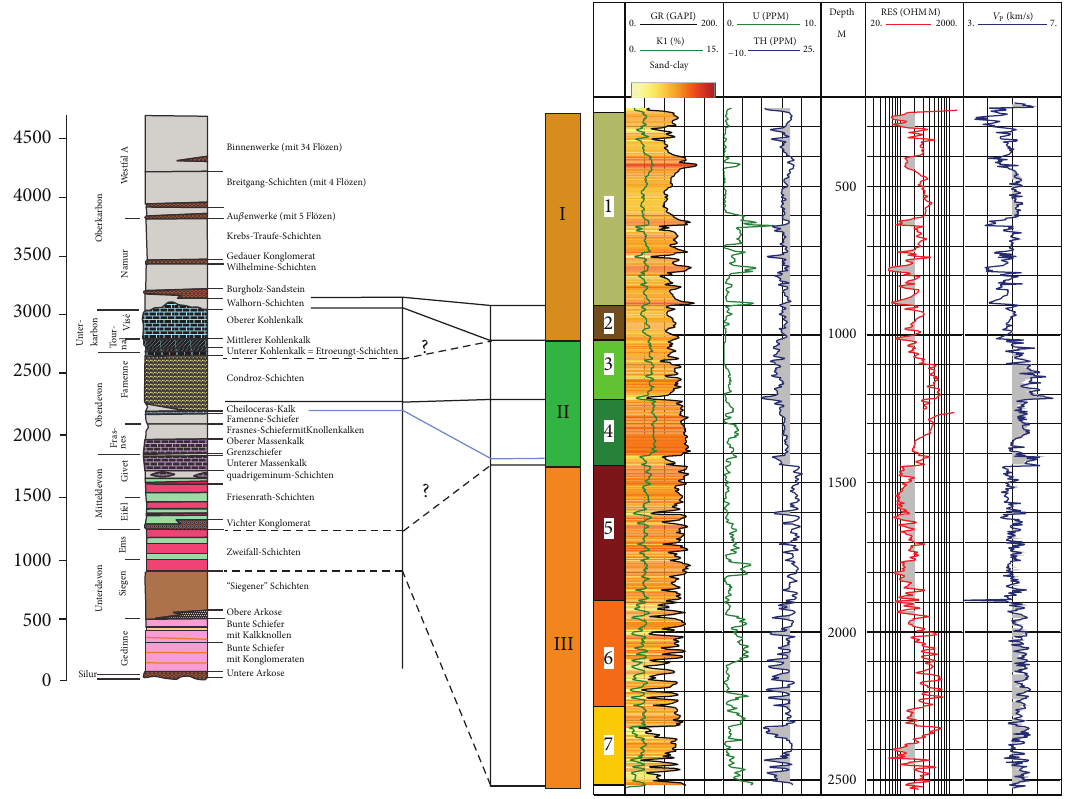
Figure 5: The borehole zonation (after logging data) and the standard stratigraphic profile known from the Eifel mountains [6].